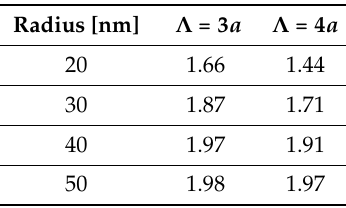
Table 3. The photocurrent enhancement for model of MNP array on Si substrate (acc. Equation (28)), for radii of MNPs a = 20, 30, 40, 50, 60 nm and the array periods Λ = 3 a , 4 a . Results obtained in the model using the correctly modified dielectric functions in their imaginary part. We used solar spectra AM1.5G to calculate the photocurrent enhancement acc. to Equation (28).